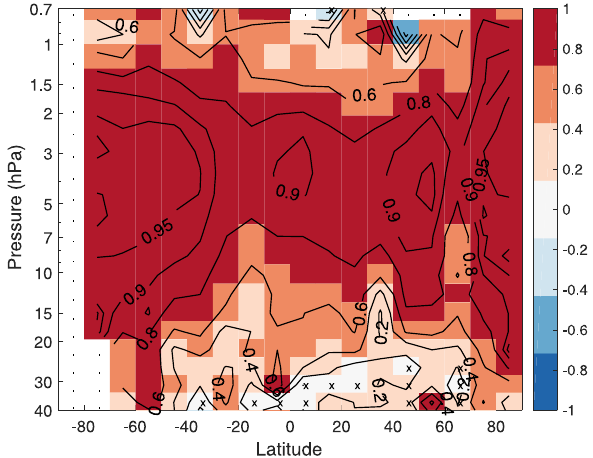
Figure 18. (a) WACCM (red) and GOMOS (blue) NO 3 5-day time series 7 December 2003–18 January 2004 in the Arctic 60–90 ◦ N at 3.7hPa. (b) MERRA temperature for the same period and